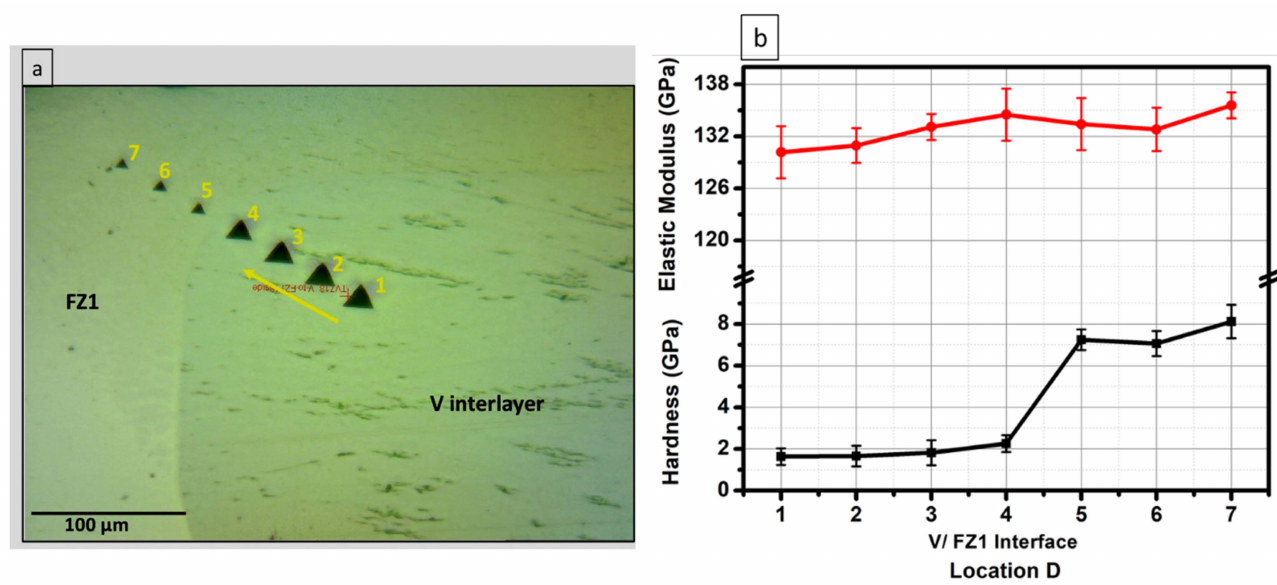
Figure 12. ( a ) Nanohardness line scan at V/FZ1 Interface (location (D) in Figure 8). ( b ) Corresponding hardness and elastic modulus profiles along the line scan.